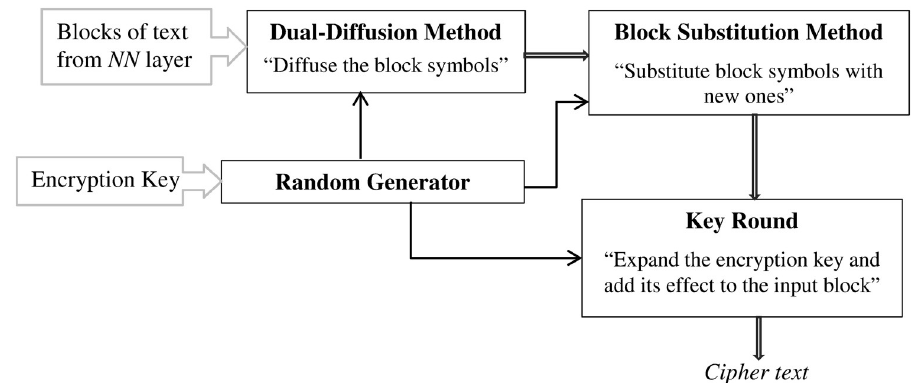
Fig 5. The control flow of the distortion